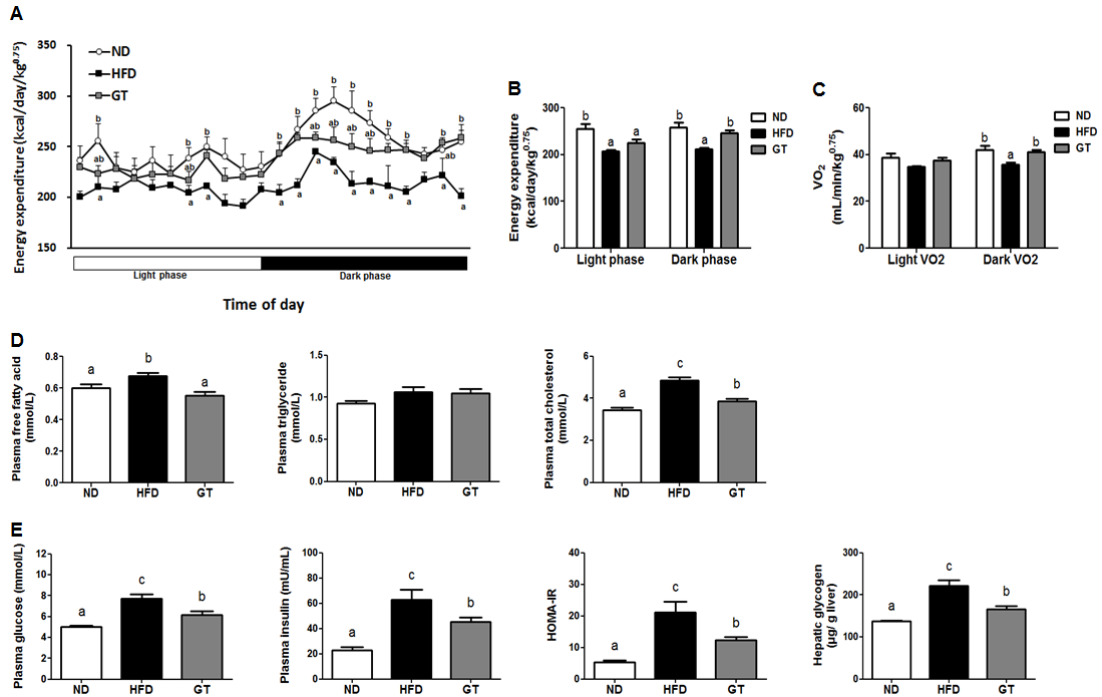
Figure 2. ( A , B ) Energy expenditure; ( C ) oxygen consumption (VO 2 ); ( D ) plasma lipid profiles; and ( E ) glucose metabolism ‐ related markers in diet ‐ induced obese C57BL/6J mice treated with green tea extract for 12 weeks. The data are shown as mean ± standard error of the mean. a–c Mean values not sharing a common superscript were significantly different among the groups ( p < 0.05). ND, normal diet, AIN ‐ 93G; HFD, high ‐ fat diet, 60% kcal from fat; GT, green tea extract (0.25%, w / w ).